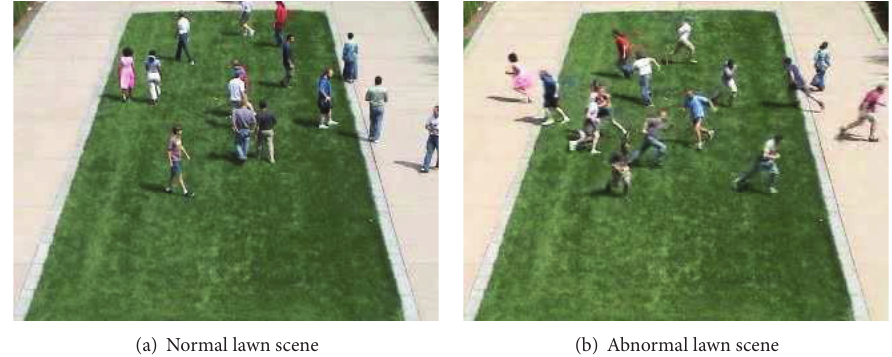
Figure 1: Examples of the normal and abnormal scenes: (a) Normal lawn scene: all the people are walking. (b) Abnormal lawn scene, all the people are running.